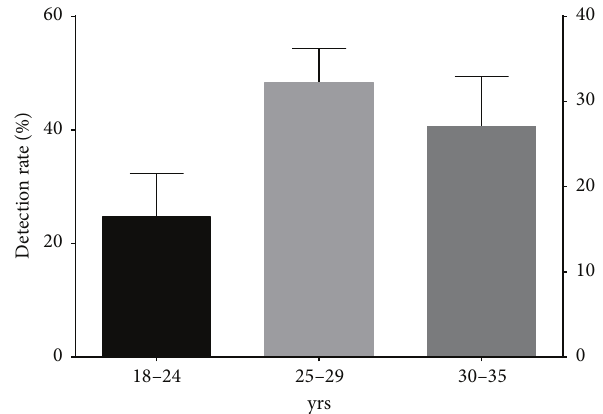
Figure 2: Mean detection rates of periodontal pathogens among women of various age groups.